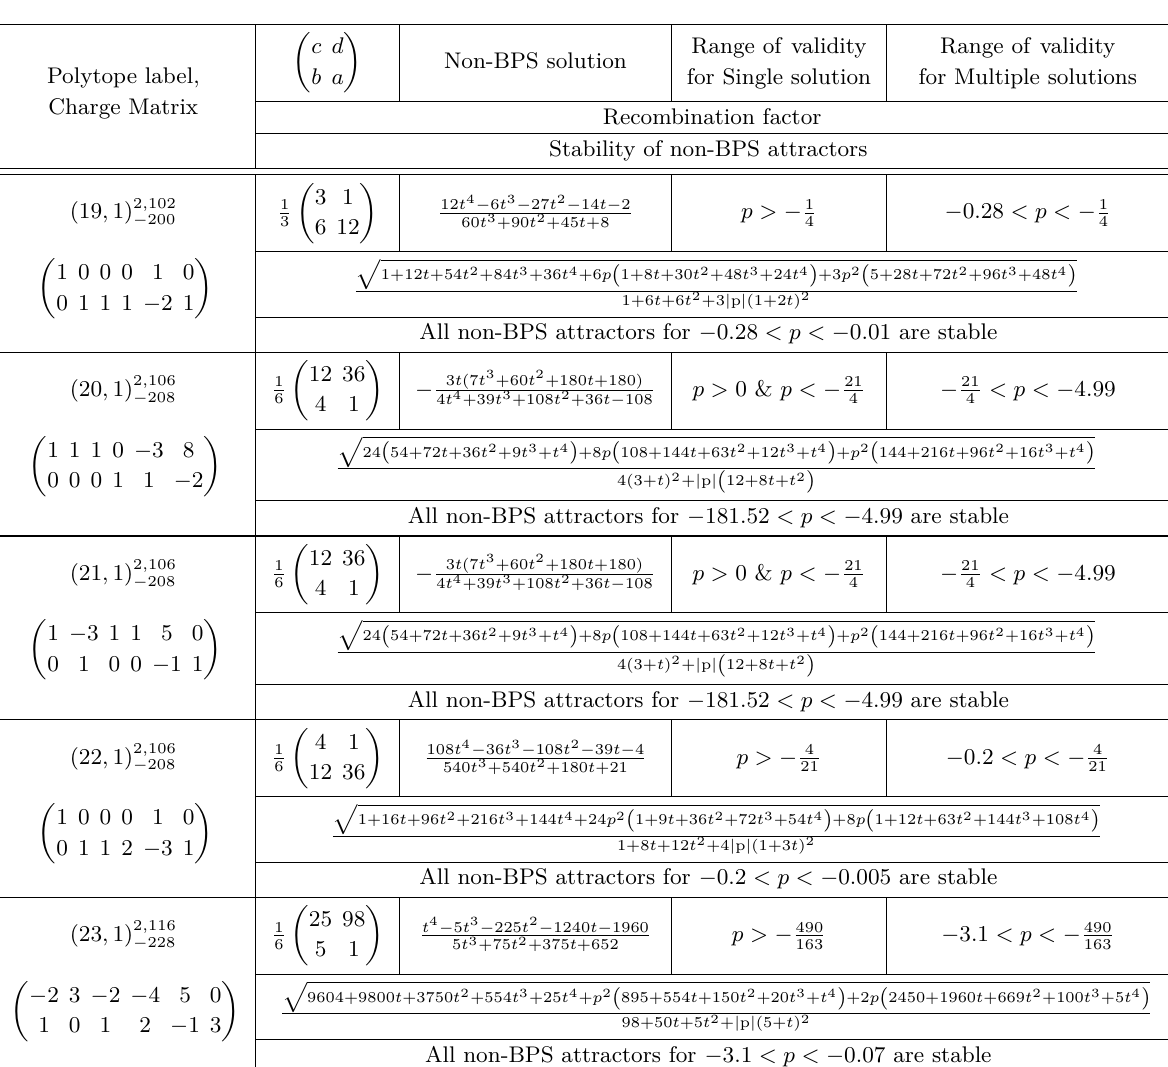
Table 15 . Non-BPS extremal (multiple) black strings in one-modulus THCY models,